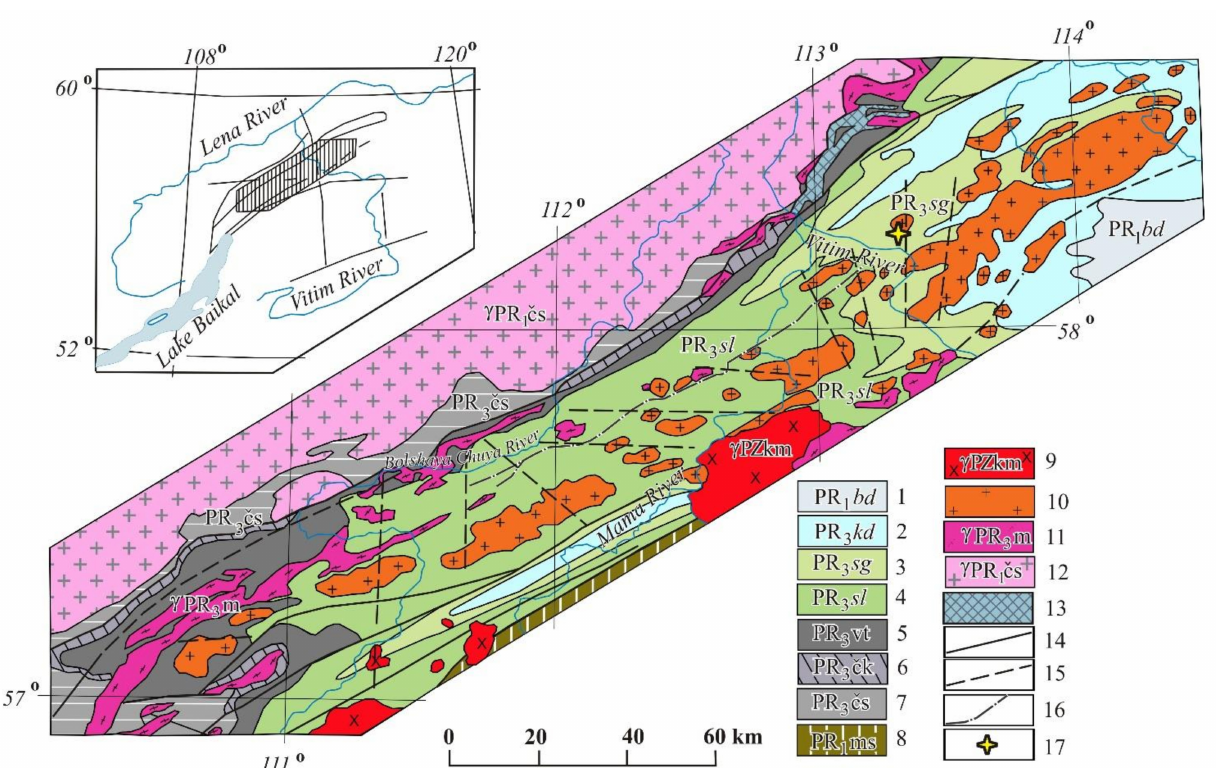
(Figure 2). Apatite and zircon were identified as accessory minerals. Zoisite and epidote are found as single grains. Minerals are unevenly distributed. The structure is coarse-grained.